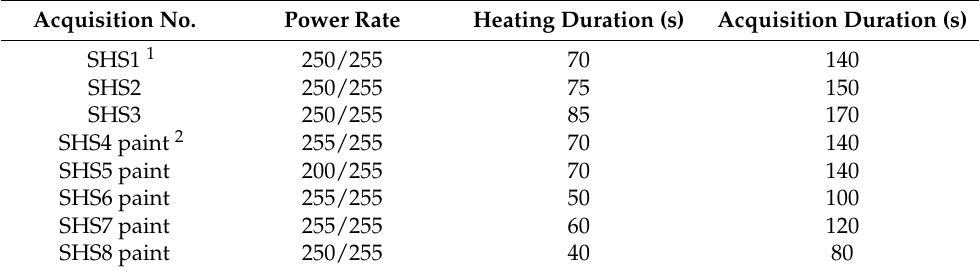
Table 9. Step-heating acquisition protocols applied to the sandwich CF-PET-CF sample. Acquisition